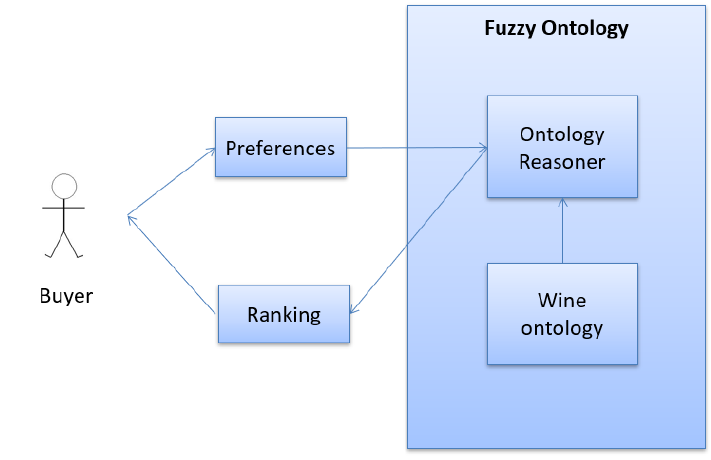
Figure 5. Designed DSS